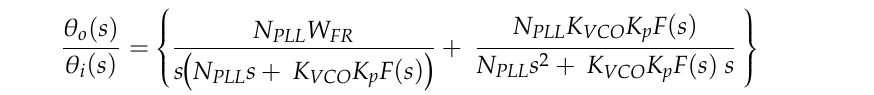
Figure 4. Frequency response of three PLLs with different filter order and same 3-dB bandwidth.